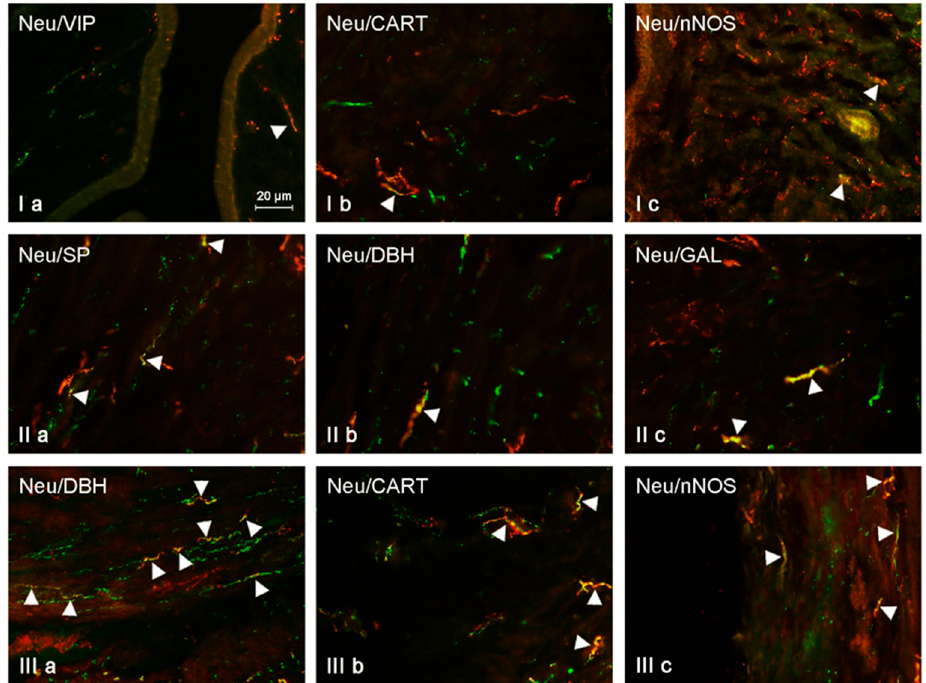
Figure 4. NRG-positive nerves (NRG-1+ green) immunoeractive to DBH, SP, VIP, nNOS, GAL, and CART (red) in the mucosal layer of the uterine horns of control animals ( a ) and pigs treated with low ( b ) and high ( c ) dose of bisphenol A. Nerves simultaneously immunoreactive to NRG-1 and other substances (yellow) are indicated with arrowheads.